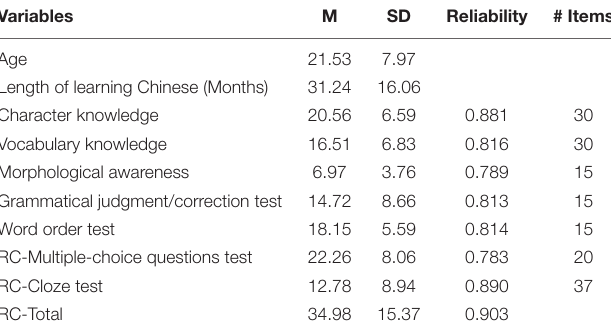
TABLE 1 | Descriptive Statistics of all the